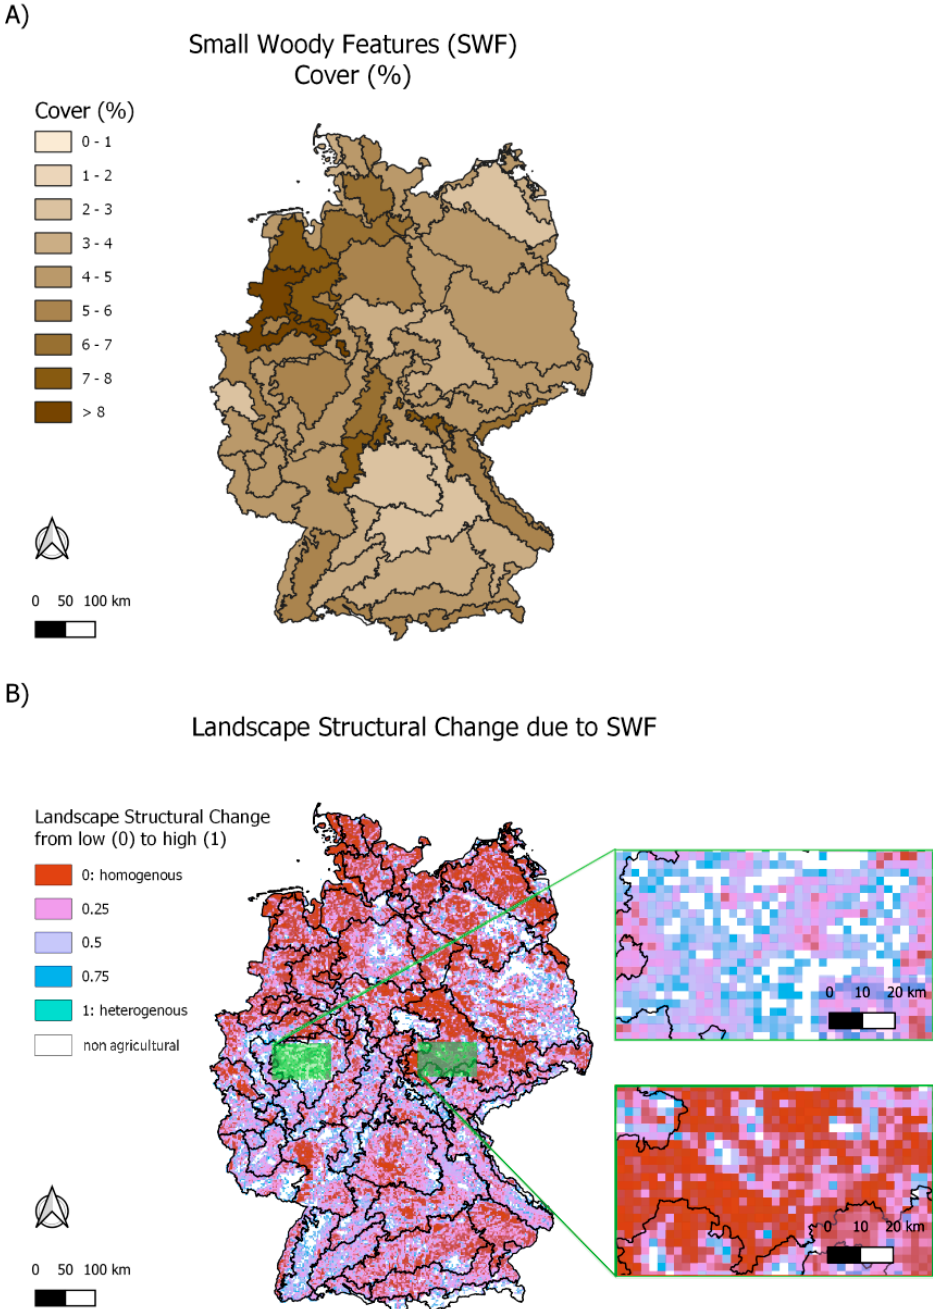
Figure 3. Density of SWFs (small woody landscape features) across 50 growing regions (BKR = Boden–Klima–Räume) ( A ). Landscape structural change arising from inclusion of small woody features (linear, patchy, and additional) into agricultural land use maps (CORINE) ( B ). Data sources: GeoBasis-DE/BKG (Bundesamt für Kartographie und Geodäsie). CORINE Land Cover 5 ha CLC5 (2015), 2021; Copernicus Land Monitoring Service—High Resolution Layer Small Woody Features—2015 reference year, 2021.